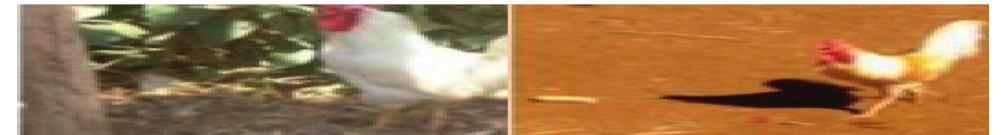
Figure 3: White plumage color indigenous ecotypes. Source: Nigussie, 2012.